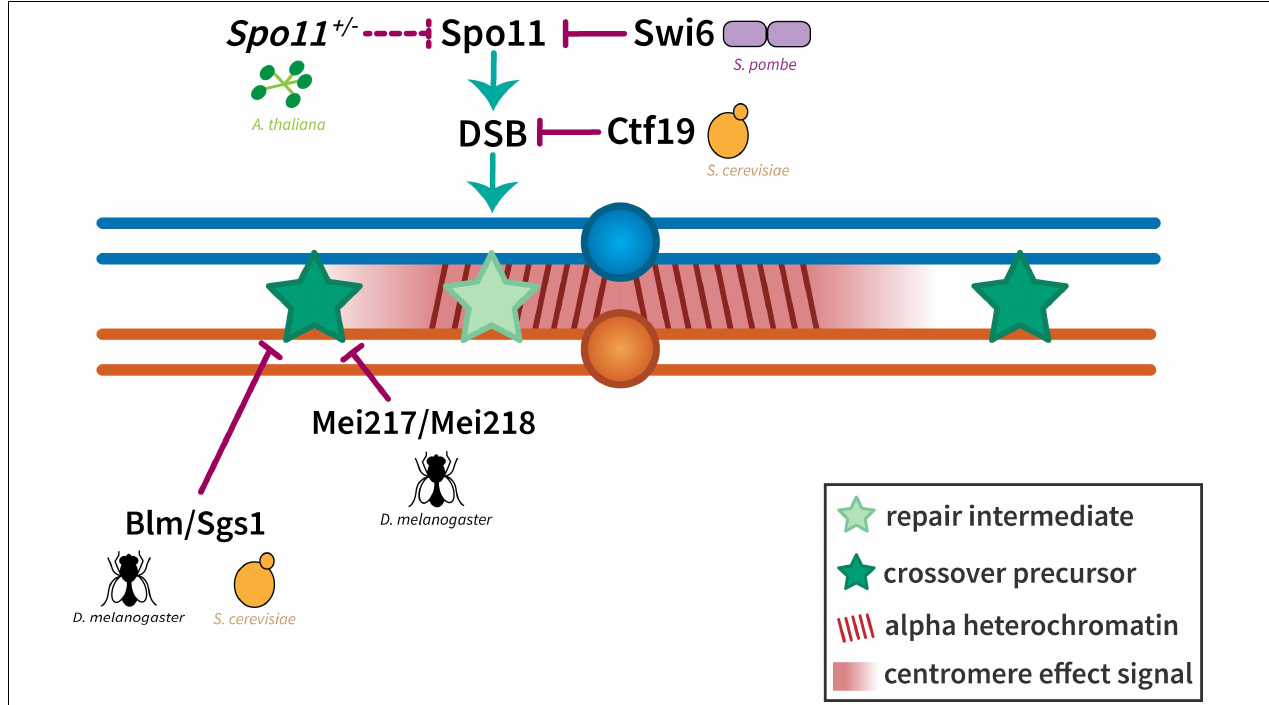
FIGURE 5 | Suppression of crossovers near the centromere. The exclusion of crossovers near the centromere seems to be enforced at two levels. Crossover suppression in the highly repetitive alpha heterochromatin has been shown to be a result of the prevention of DSBs either through local chromatin organization (in S. cerevisiae ) or the inactivation of Spo11 (in S. pombe and A. thaliana ). Crossover suppression in the less repetitive beta heterochromatin and the proximal euchromatin has been shown to be regulated through Bloom syndrome helicase/Sgs1 (in D. melanogaster and S. cerevisiae ) and dependent on distance from the centromere (represented by a centromere effect signal shown in red). Homologous chromosomes are shown in blue and orange with dark red lines in the pericentromeric region representing alpha heterochromatin. Light and dark green stars represent repair intermediates and crossover precursors,